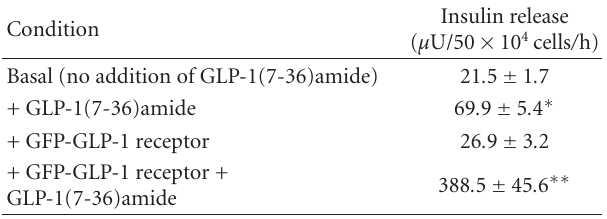
Table 2: E ff ect of GLP-1(7-36)amide on insulin release from Rin m5F cells transiently expressing human GFP-GLP-1 receptor. Each bar with the indicated standard deviation represents the mean value of five independent experiments done in duplicate. ANOVA: F(3, 16) = 291 . 6 ; P < .0001. Tukey-Kramer multiple comparison test was used to reveal significant di ff erences between groups of